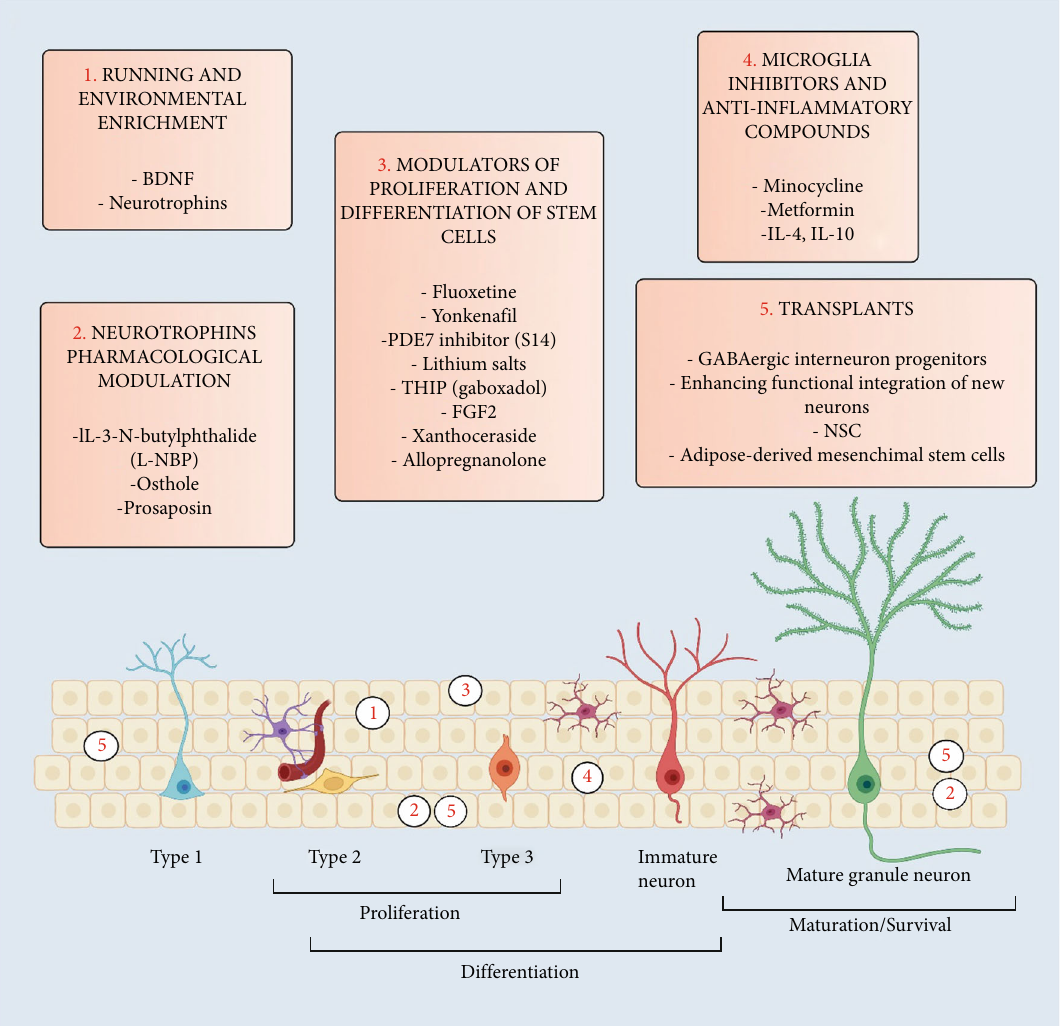
Figure 2: Factors that rescue AHN. Top boxes: factors that increase AHN. (1) Physical activity and environmental enrichment increase neurotrophin levels including BDNF, which in turn stimulate NSC proliferation and di ff erentiation. Consistently, pharmacological modulation of neurotrophins (2) through compounds including L-NBP, Osthole, or Prosaposin can initiate NSC proliferation and also promote survival of newborn neurons. (3) Other modulators of proliferation and di ff erentiation of stem cells can act to potentiate the generation of newborn neurons and their neuron fate speci fi cation. (4) Microglia can be found in 3 distinct states, each one a ff ecting AHN through di ff erent mechanisms. Resting microglia ensure basal neurogenesis by releasing factors that control neuronal di ff erentiation. Active microglia release proin fl ammatory cytokines that reduce NSC proliferation and di ff erentiation. Congruent with this, microglia inhibitors and anti-in fl ammatory compounds rescue AHN in AD mice. Alternatively acting state microglia release anti- in fl ammatory cytokines including IL-4 and IL-10 that favor di ff erentiation, viral-mediated expression of these cytokines reduces astro/ microgliosis and enhances AHN. (5) Transplants of stem cells or progenitors as well as enhancing the functional integration of new neurons can potentiate AHN. Enhancing GABA signaling through transplant of GABAergic progenitors favors the maturation of newborn neurons. Transplanted NSCs in the hippocampus can di ff erentiate in neurons or astrocytes. Mesenchymal stem cell transplantation increases neurogenesis by boosting di ff erentiation and proliferation through mechanisms including the stimulation of alternatively activated microglia. Bottom panel: factors that increase AHN are represented along the stages of spatio-temporal transition of neural stem cell to a mature neuron. Numbers refer to the action of factors reported in top boxes. Please note that numbers position is indicative but not de fi nitive as each factor can act through di ff erent